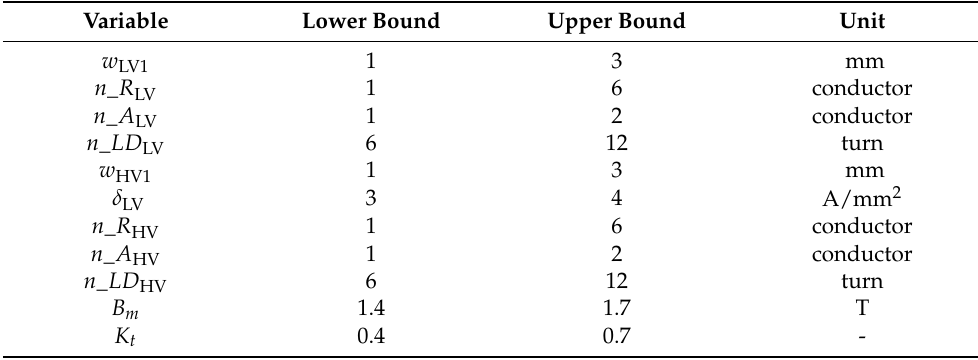
Table 1. The lower and upper bounds of the optimized design